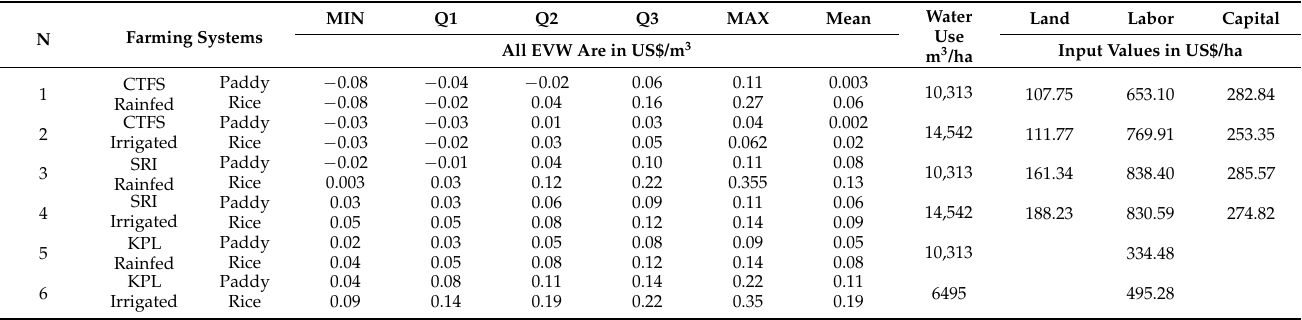
Table 5. Summary of descriptive economic value of water with other inputs of production.